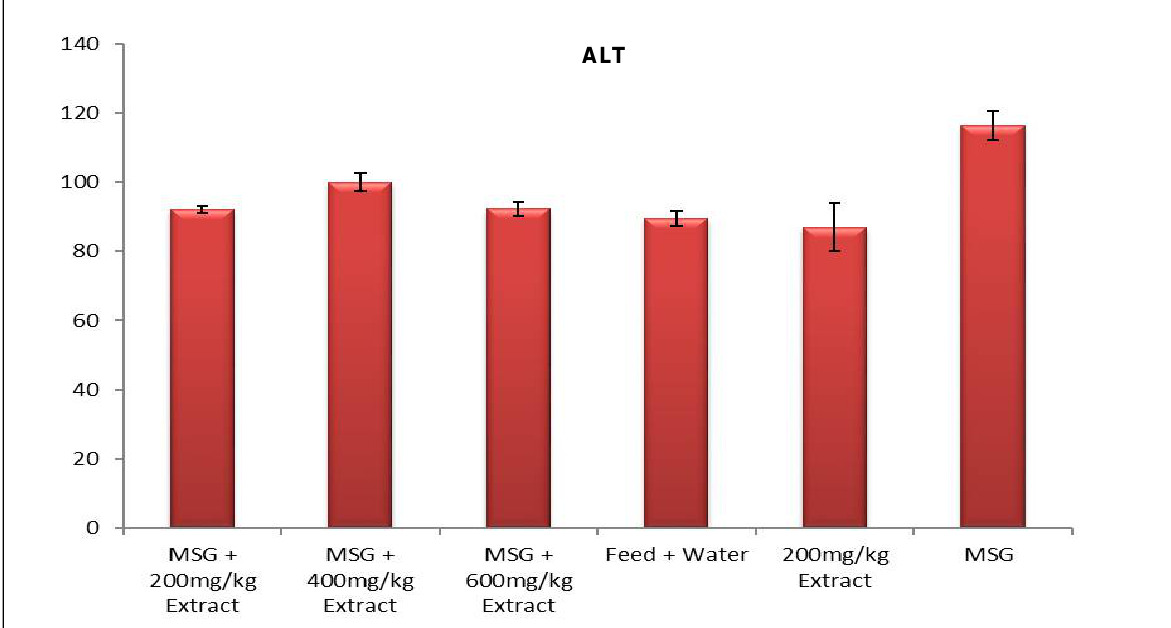
ratsALT Figure 2: Effect of methanol extract of N. laevis on ALT activity (IU/L) of the Figure 3: Effect of methanol extract of N. laevis on ALP activity (IU/L) of the